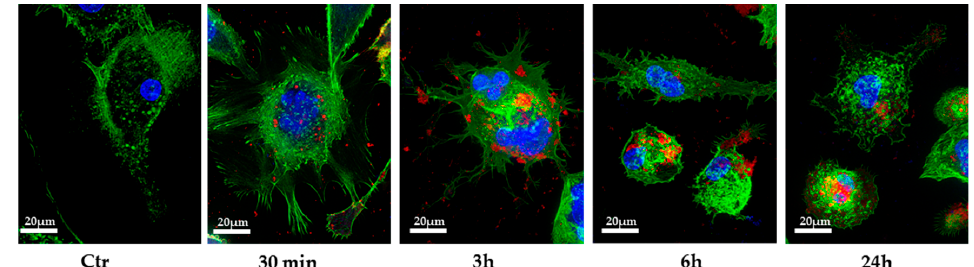
Figure 3. Intracellular localization of EVs. TPA-differentiated THP-1 cells were exposed to 100 μ g/mL DiD’-stained PC3-EVs. At the indicated time points, cells were fixed, actin filaments were stained with FITC-labeled phalloidin and nuclei were counterstained with DAPI. The images are representative of one out of three separate experiments. Magnification 63×.